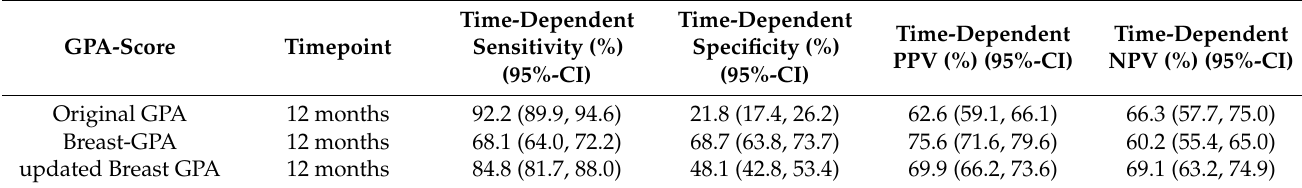
Table 5. Diagnostic accuracy of the original GPA, the Breast-GPA and updated Breast-GPA score at the time of 12 months for a cut off value of 3, comparing the highest category versus the three lower categories of each